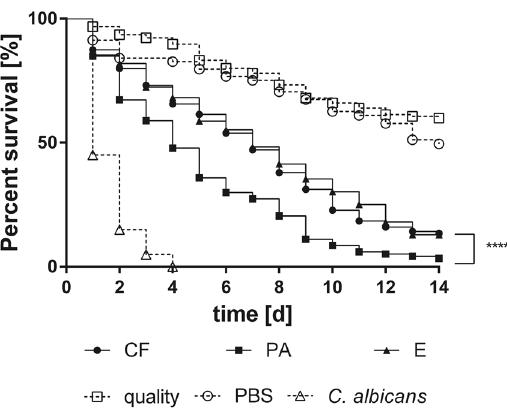
Figure 5. Comparison of the mean survival curves of the three strain groups of E. dermatitidis isolates: isolates from cystic fibrosis patients (CF), isolates from Asian patients with systemic infections (P), and environmental isolates (E). P strains exhibited a significantly higher virulence against G. mellonella than E strains or CF strains. Curves were compared with the Mantel-Cox log-rank test with significance set at the level of P ≤ 0.05. * P ≤ 0.05; ** P ≤ 0.01; *** P ≤ 0.001; **** P ≤